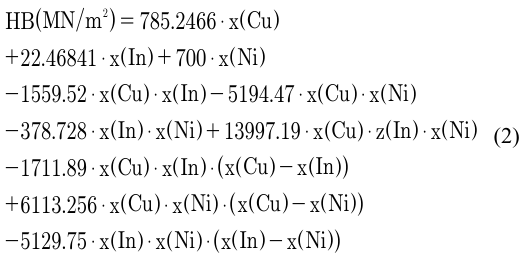
Ni , b) In-Cu Ni and 0.5 0.5 0.8 0.2